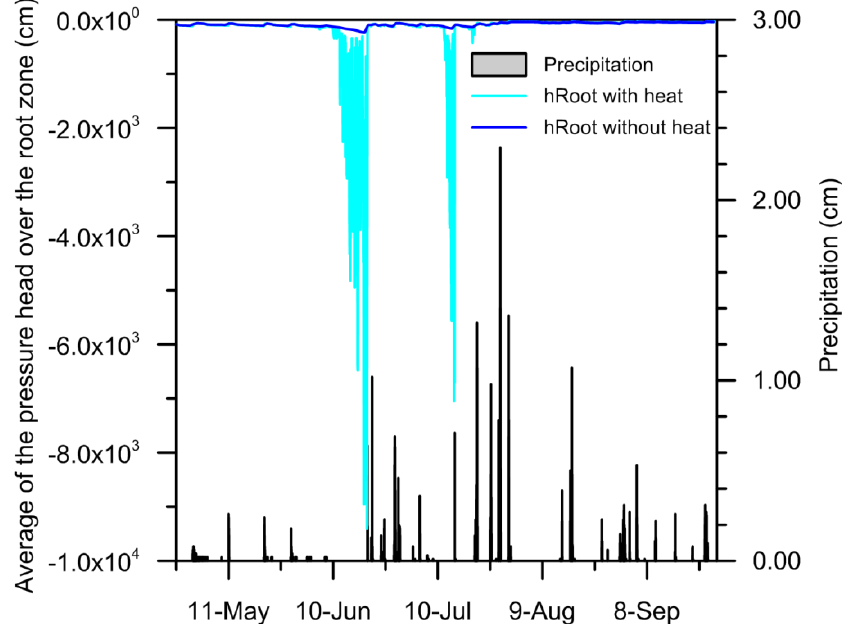
Figure 7. Comparison of the mean pressure head values over the root zone with heat flow ( hRoot with heat) and without heat flow ( hRoot without heat).